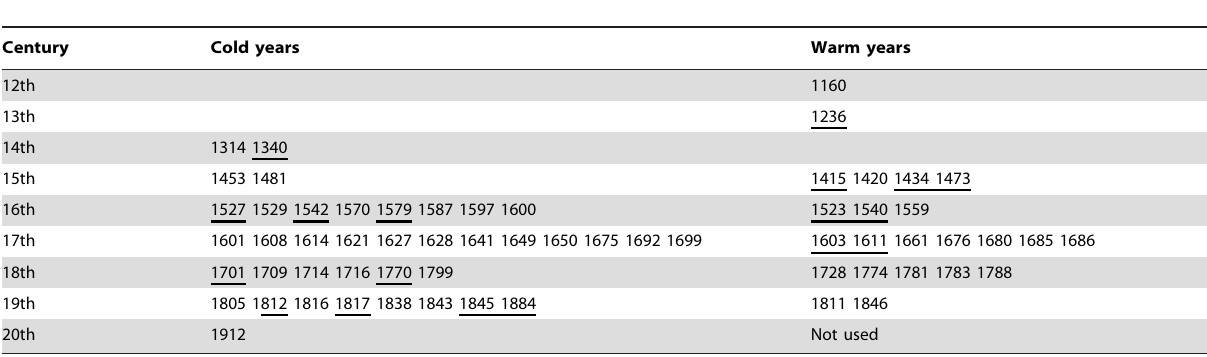
Table 2. List of the cold and warm springs and/or summers.